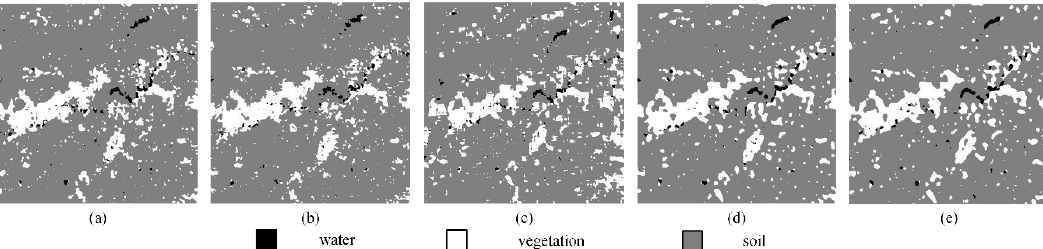
Figure 13. Comparison of the results of different SPM models for an artificial land image with a scale of 8. ( a ) PSA result, ( b ) PSA_SA result, ( c ) DSAM result, ( d ) PSA_MSA1 result, ( e ) PSA_MSA2 result.